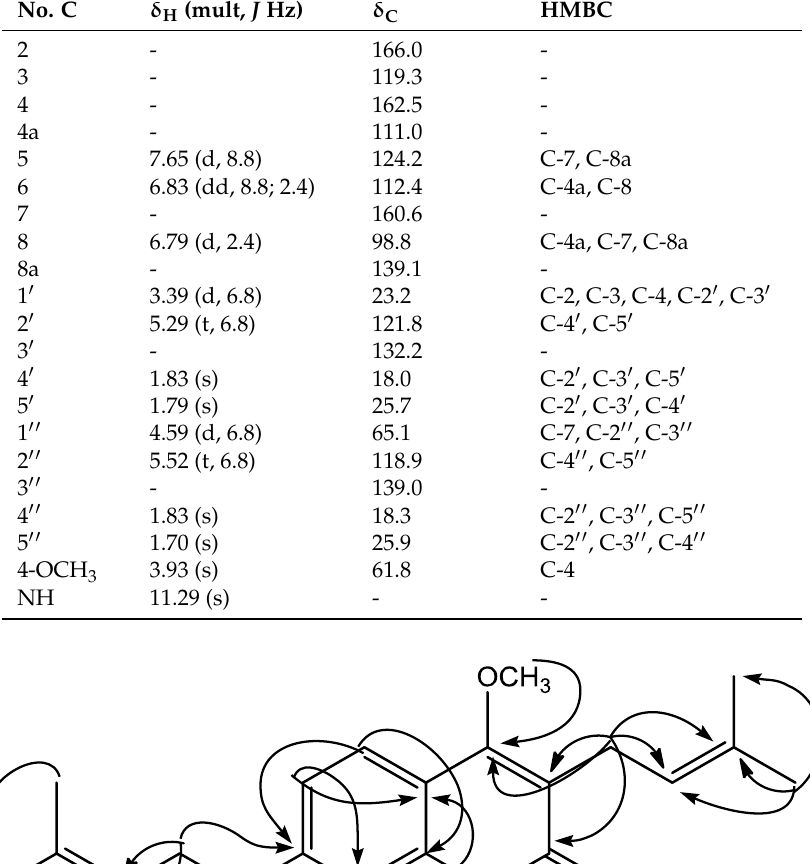
Table 1 . NMR spectroscopic data of 4-methoxy-3-(3-methylbut-2-en-1-yl)-7-[(3-methylbut-2-en-1- yl)oxy]quinolin-2(1 H )-one in CDCl 3 . No.C